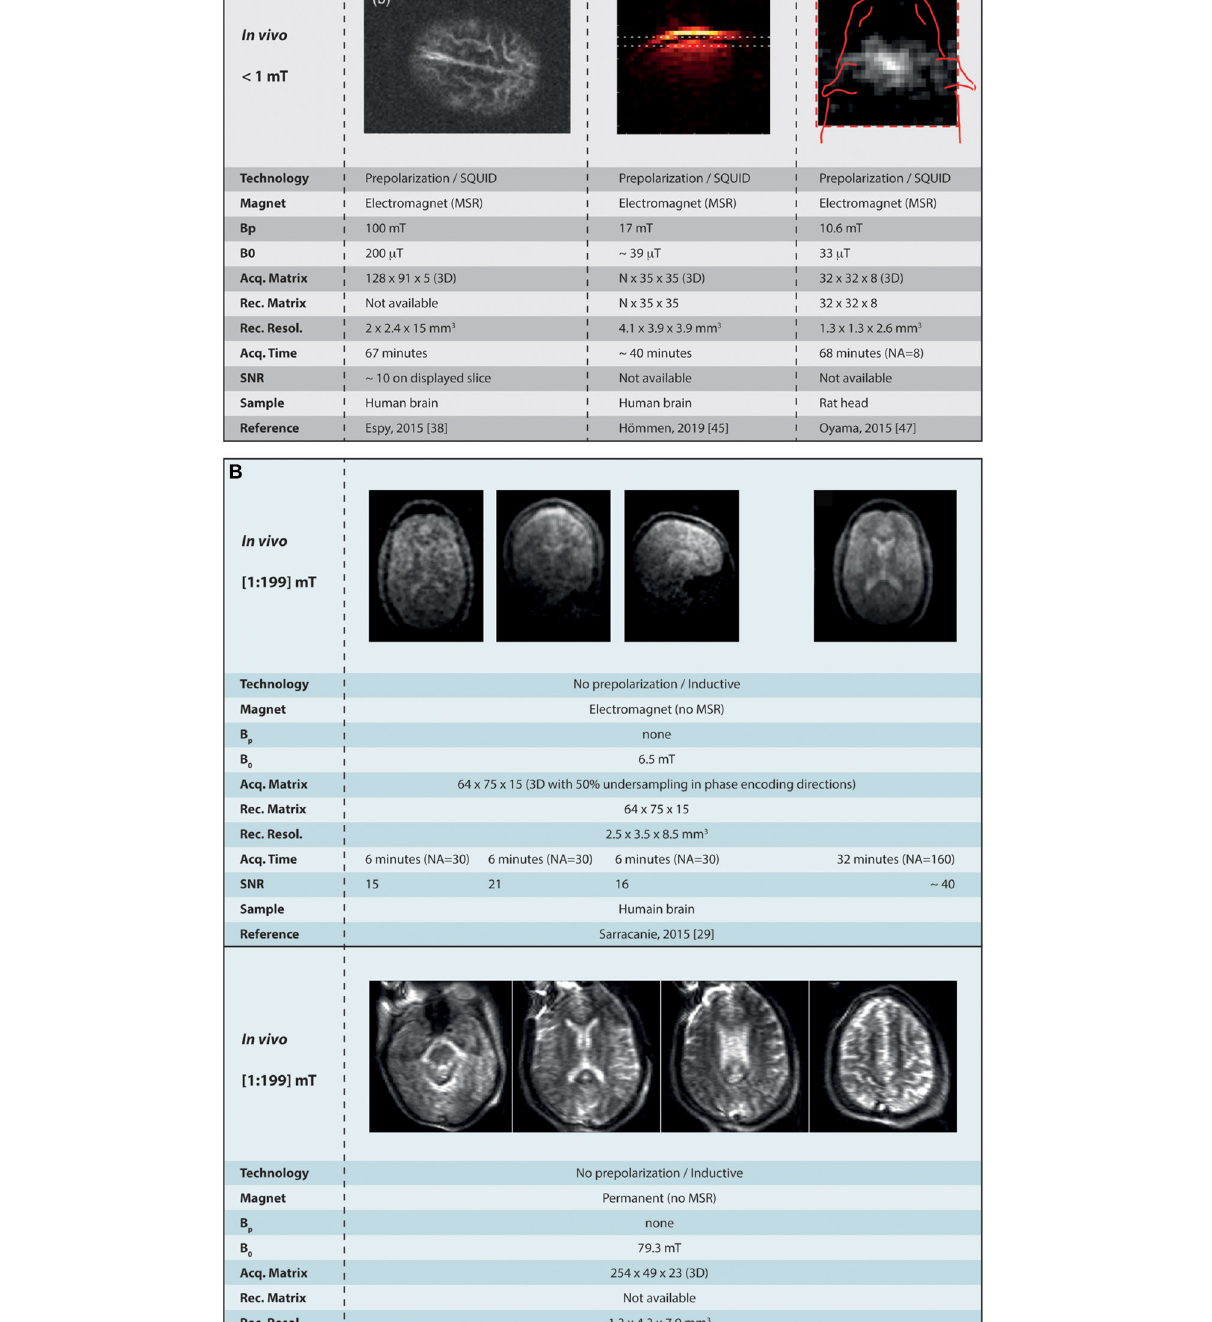
Frontiers in Physics |